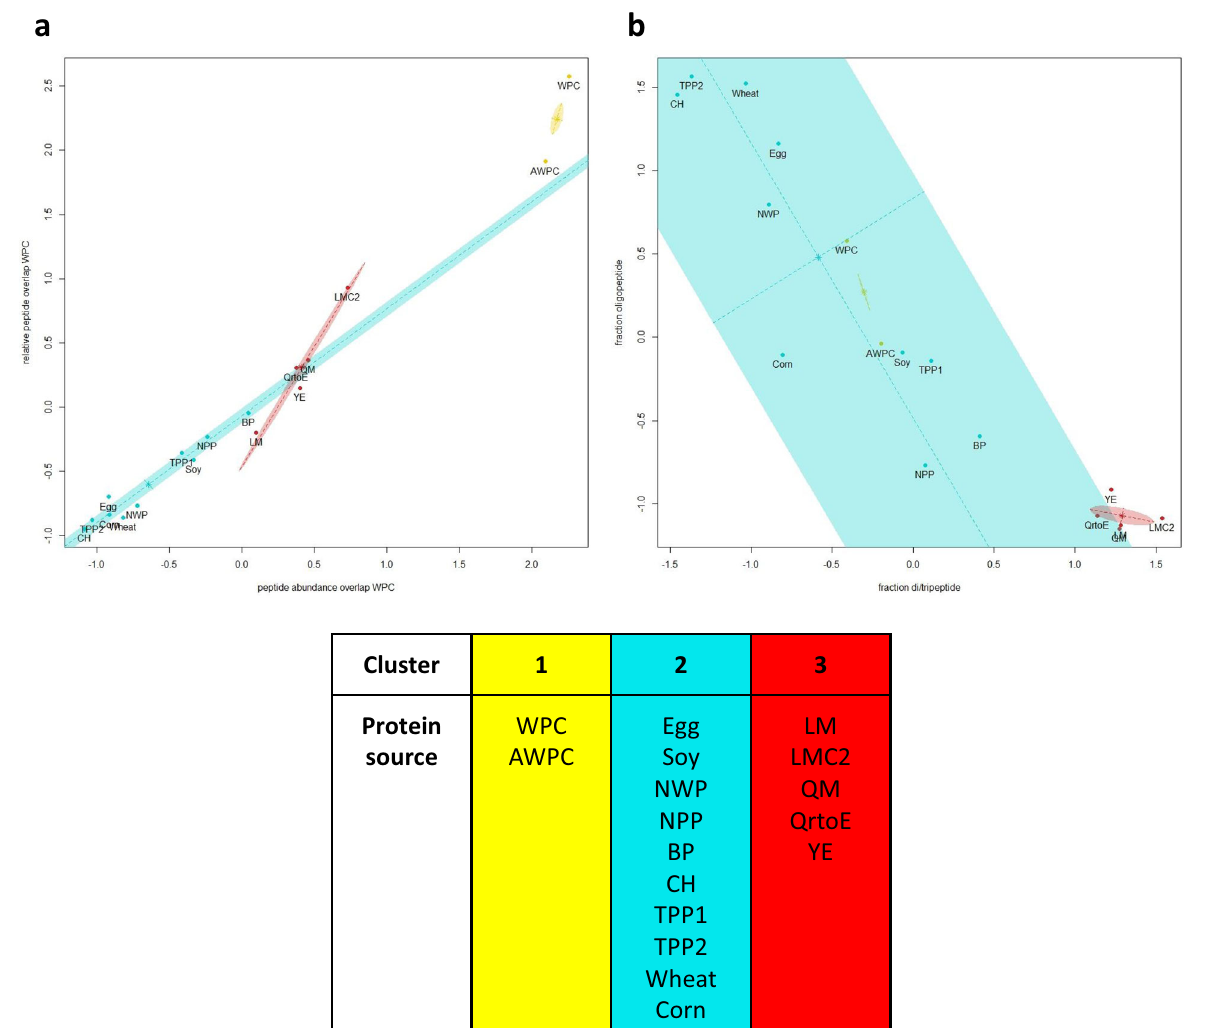
Fig. 1 Holistic clustering of potential dietary protein based on proteomic data. The optimal cluster method ellipsoidal, equal volume, shape, and variable orientation (EEV) and number of clusters (3) were determined using the Bayesian Information Criterion. a This two- component plot shows relative peptide overlap to total peptide count in WPC on the vertical axis and relative peptide abundance of WPC overlapping peptides on the horizontal axis. b Two-component plot showing fraction oligopeptides on the vertical axis and fraction di/ tripeptides on the horizontal axis. Supplementary Fig. 4 shows all combinations of two-component plots. Analysis was done based on digest peptide pro fi les, ion peak overlap, quantity of WPC-matched ion peaks relative to total protein ion peaks and relative abundance of WPC- matched ion peaks.